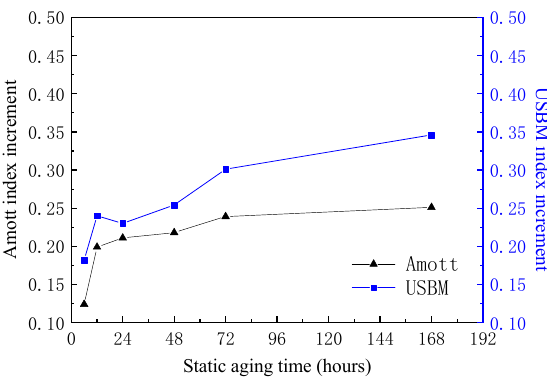
Figure 6. Wettability-index increment vs. static-aging time.